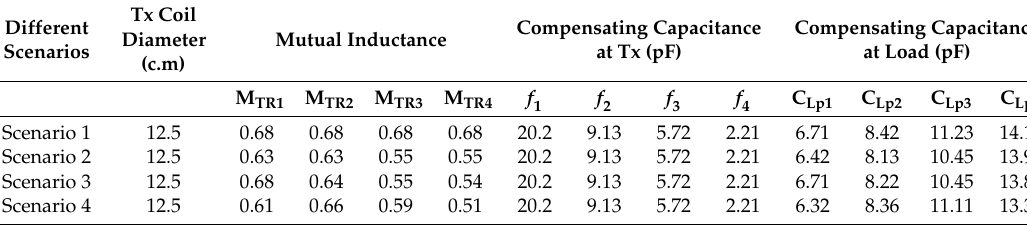
Table 3. Calculated Compensation Capacitance for different Scenarios.